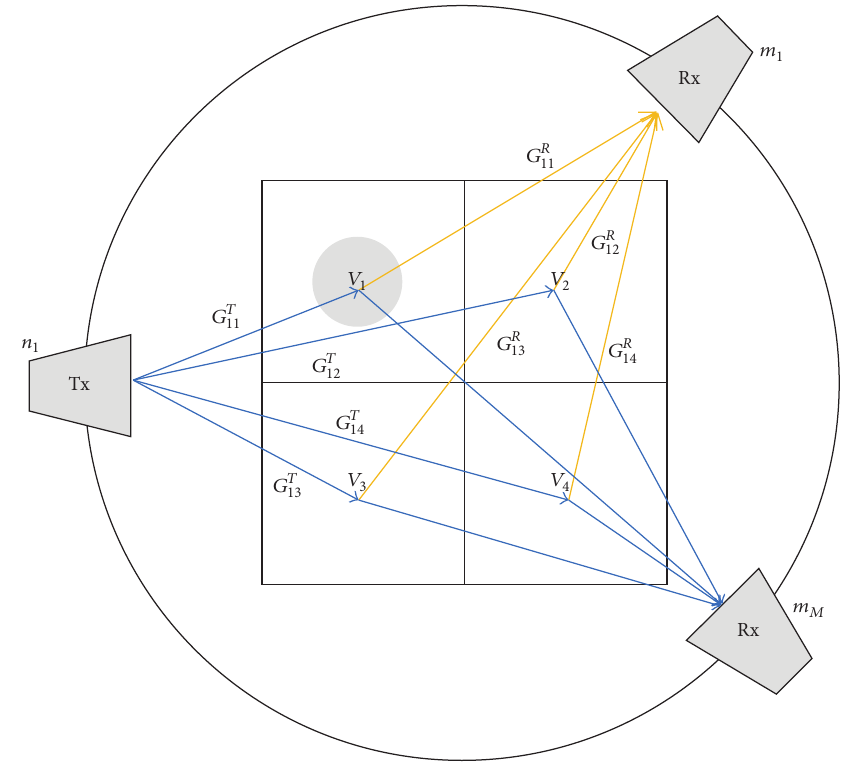
Figure 3: The formation of the measurement domain as cells.